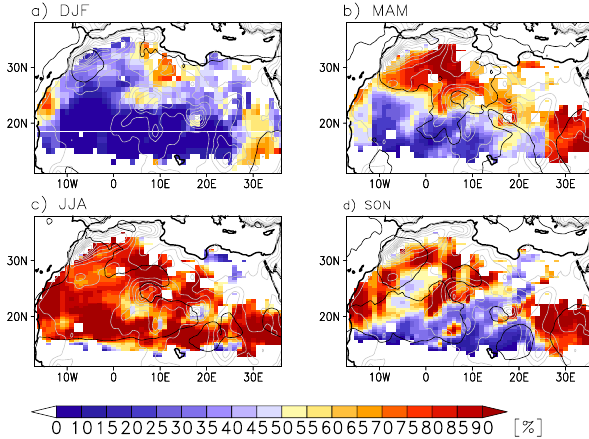
Figure 10. Seasonal fraction of dust emission amount associated with atmospheric depressions. Shown are fractions of total dust emission associated with depressions in percent for (a) December– February, (b) March–May, (c) June–August and (d) September– November averaged for 1989–2008 (shaded). Dust emission within a radius of 10 ◦ from the depression centre is considered (Sect. 2). Areas within the black contour have an occurrence frequency of depression of more than 2% (Fig. 2). Grey contours show the orog- raphy in steps of